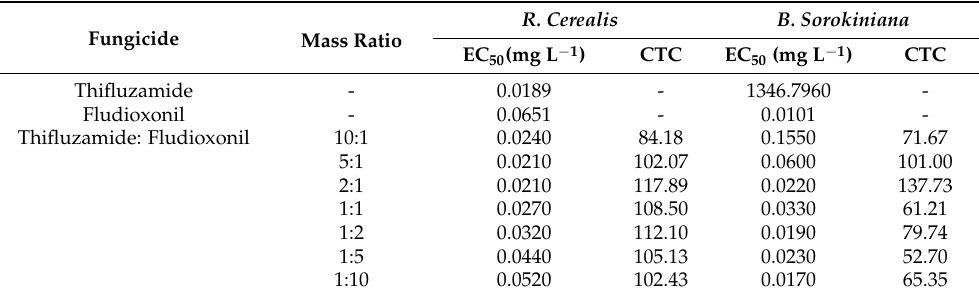
Table 1. Experimental design of the fungicide co-formulations and their effectiveness against R. cerealis and B. sorokiniana